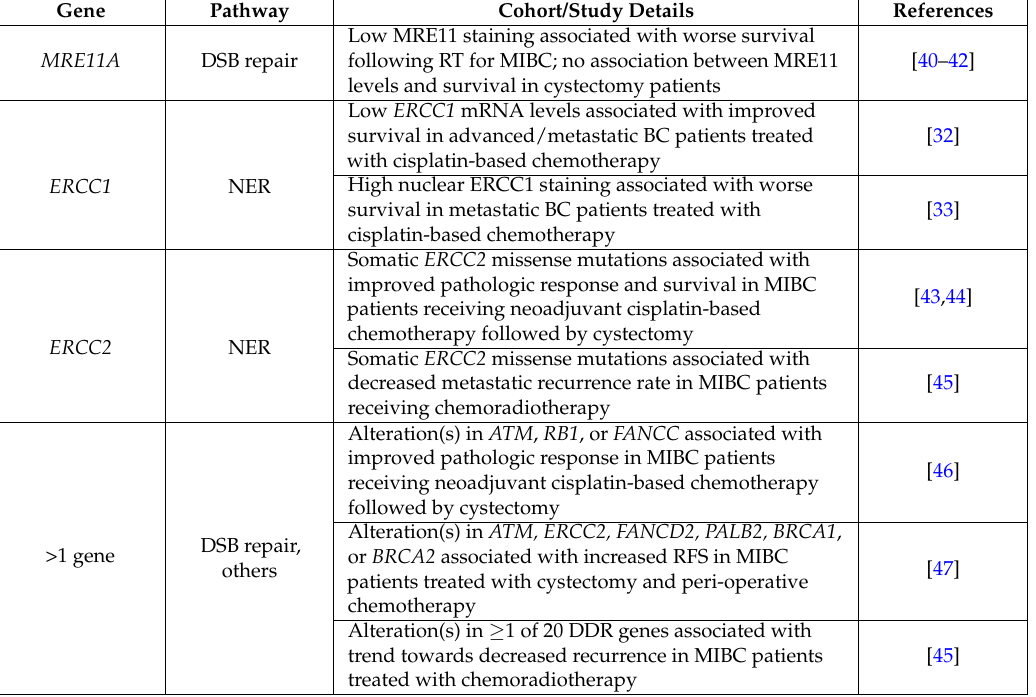
Table 1. Clinical implications of select DNA repair pathway alterations in bladder